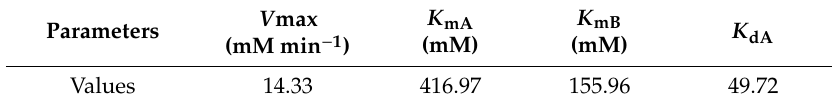
Table 3. Kinetic constants of lipase-catalyzed acidolysis in the synthesis of DHA + EPA ethyl